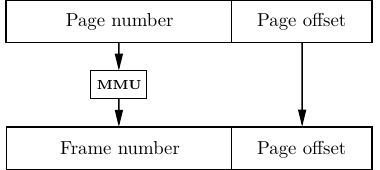
Figure 2: Virtual-to-physical address